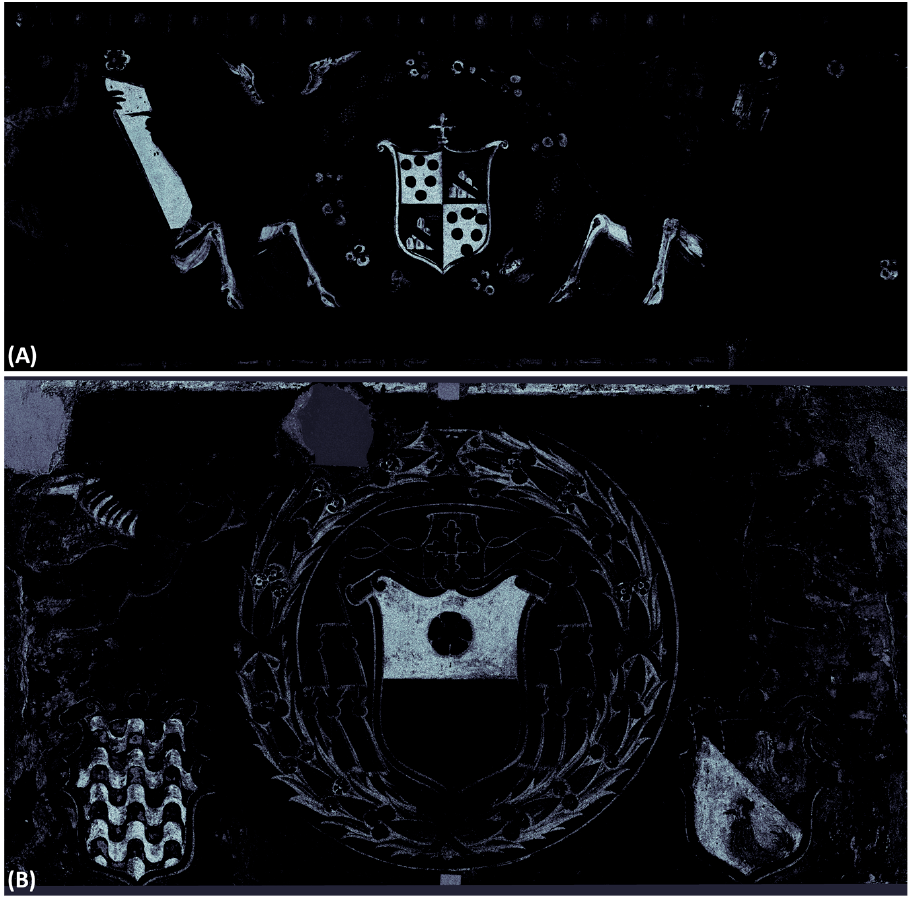
Figure 11. Result of the spectral similarity algorithm applied to the yellow ochre in the frieze ( A ) and in the blue smalt in the Riario coat of arms ( B ).